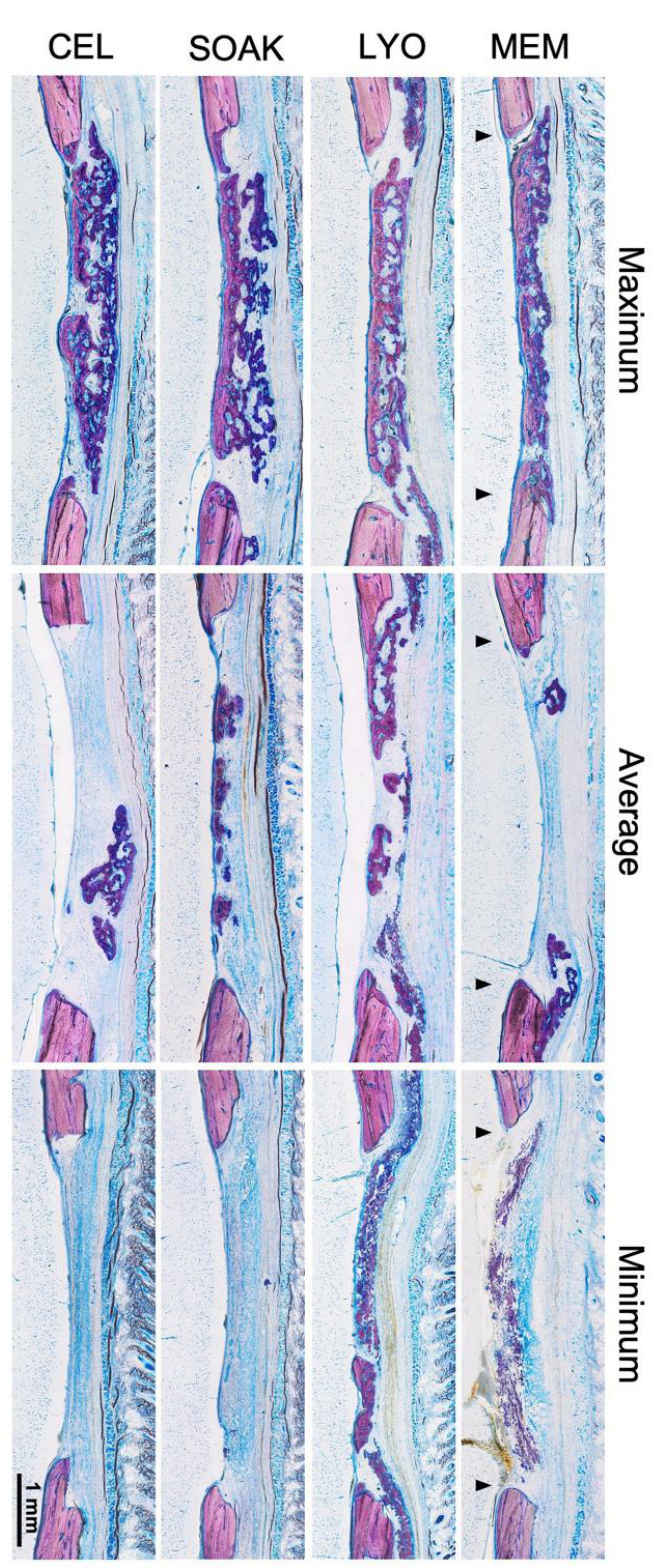
Figure 4. Histological analysis. Representative histological images after 4 weeks showing maximum, average and minimum bone regeneration in the different groups. Arrows indicate the defect edges. MEM, native membrane; LYO, lyophilized membrane with conditioned media; SOAK, soaked membrane with conditioned media; CEL, membrane with rMSC. Scale bar: 1 mm.